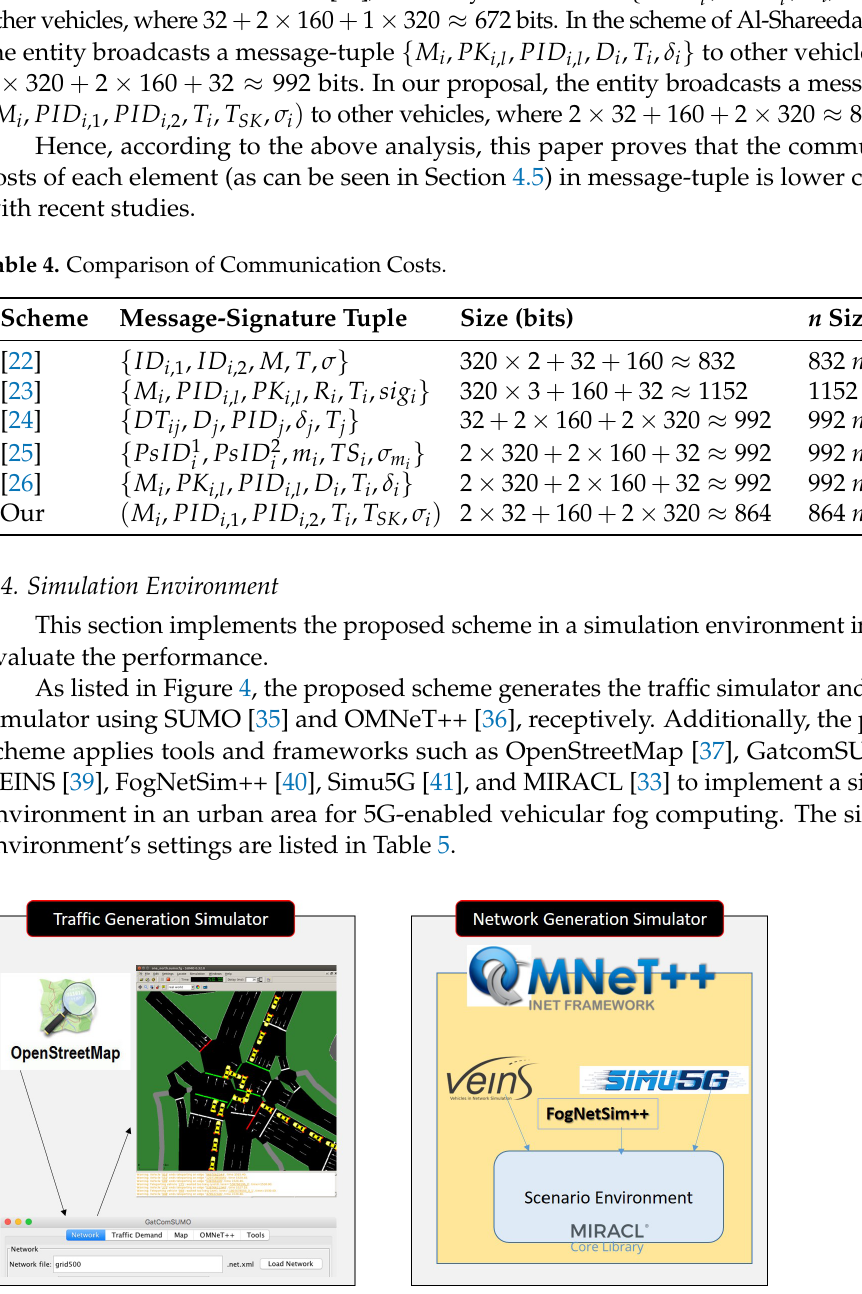
Figure 4. Simulation Environment of Proposed